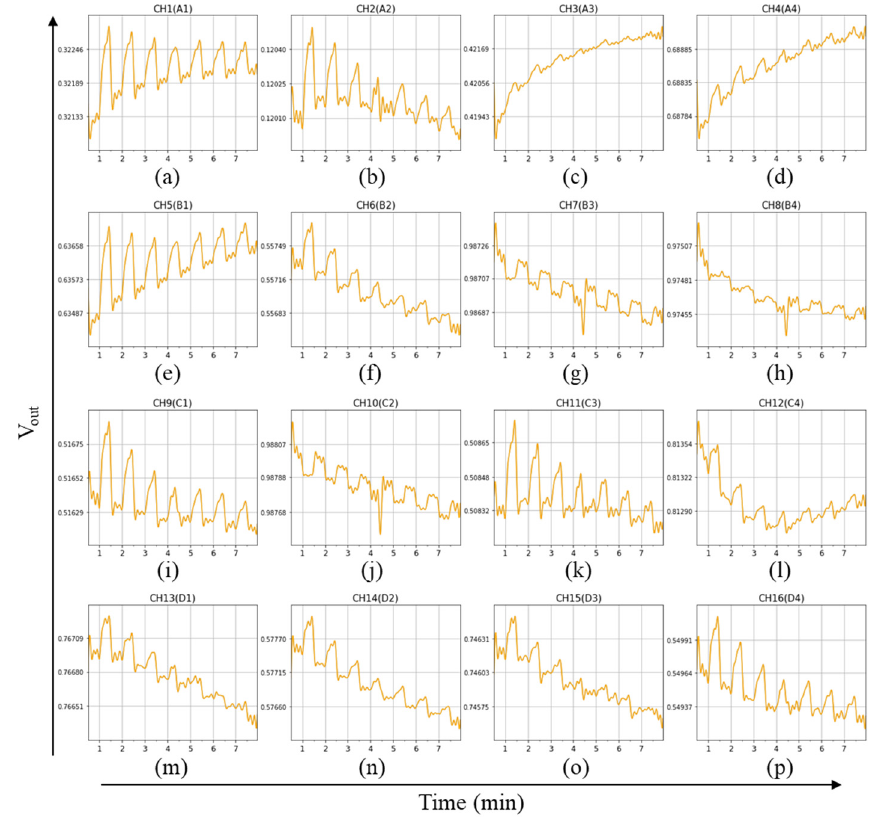
Figure 5. Sensor responses of MV cable A using array A with 16 types of high-polarity GC materials.